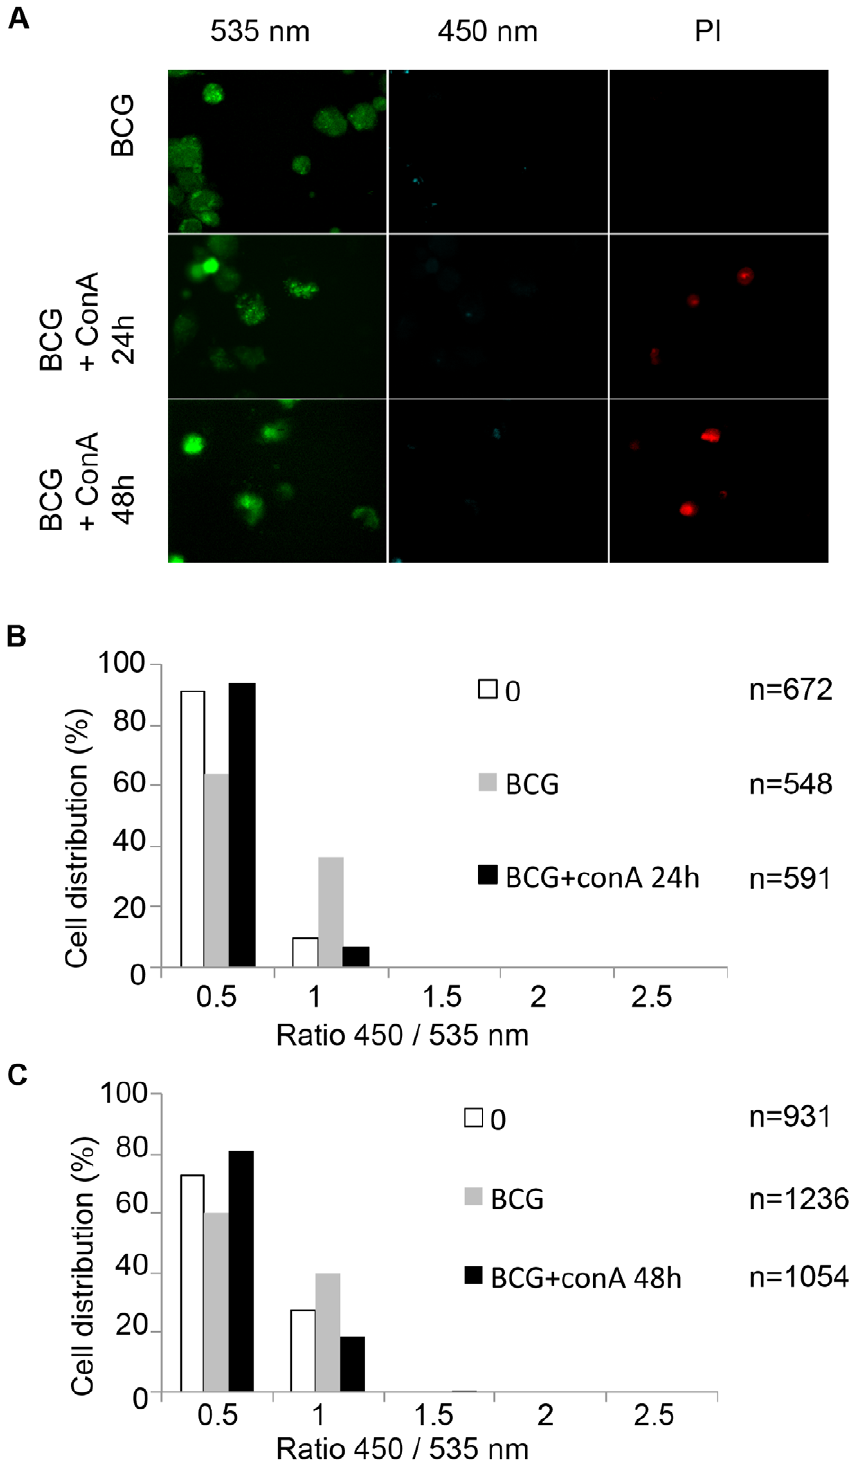
Figure 5. Necrosis induction does not lead to the release of mycobacteria from the phagolysosome to the cytosol. THP-1 cells were infected with BCG at a MOI of 1 for 2 days before necrosis induction using 100 m g/ml concanavalin A for 24 h or 48 h. After CCF-4 loading for 2 h, cells were incubated 5 minutes in the presence of 2 m g/ml propidium iodide (PI) and then subjected to PFA fixation. Cells were imaged using fluorescence widefield Nikon Ti microscope with 40X objective (A). Picture acquisition was achieved randomly and automatically for each condition on 49 fields and further 450/535 nm intensity ratio measurements (B,C) were obtained through analysis by a specialized algorithm using the Metamorph software. The plots were representative of 2 independent experiments.